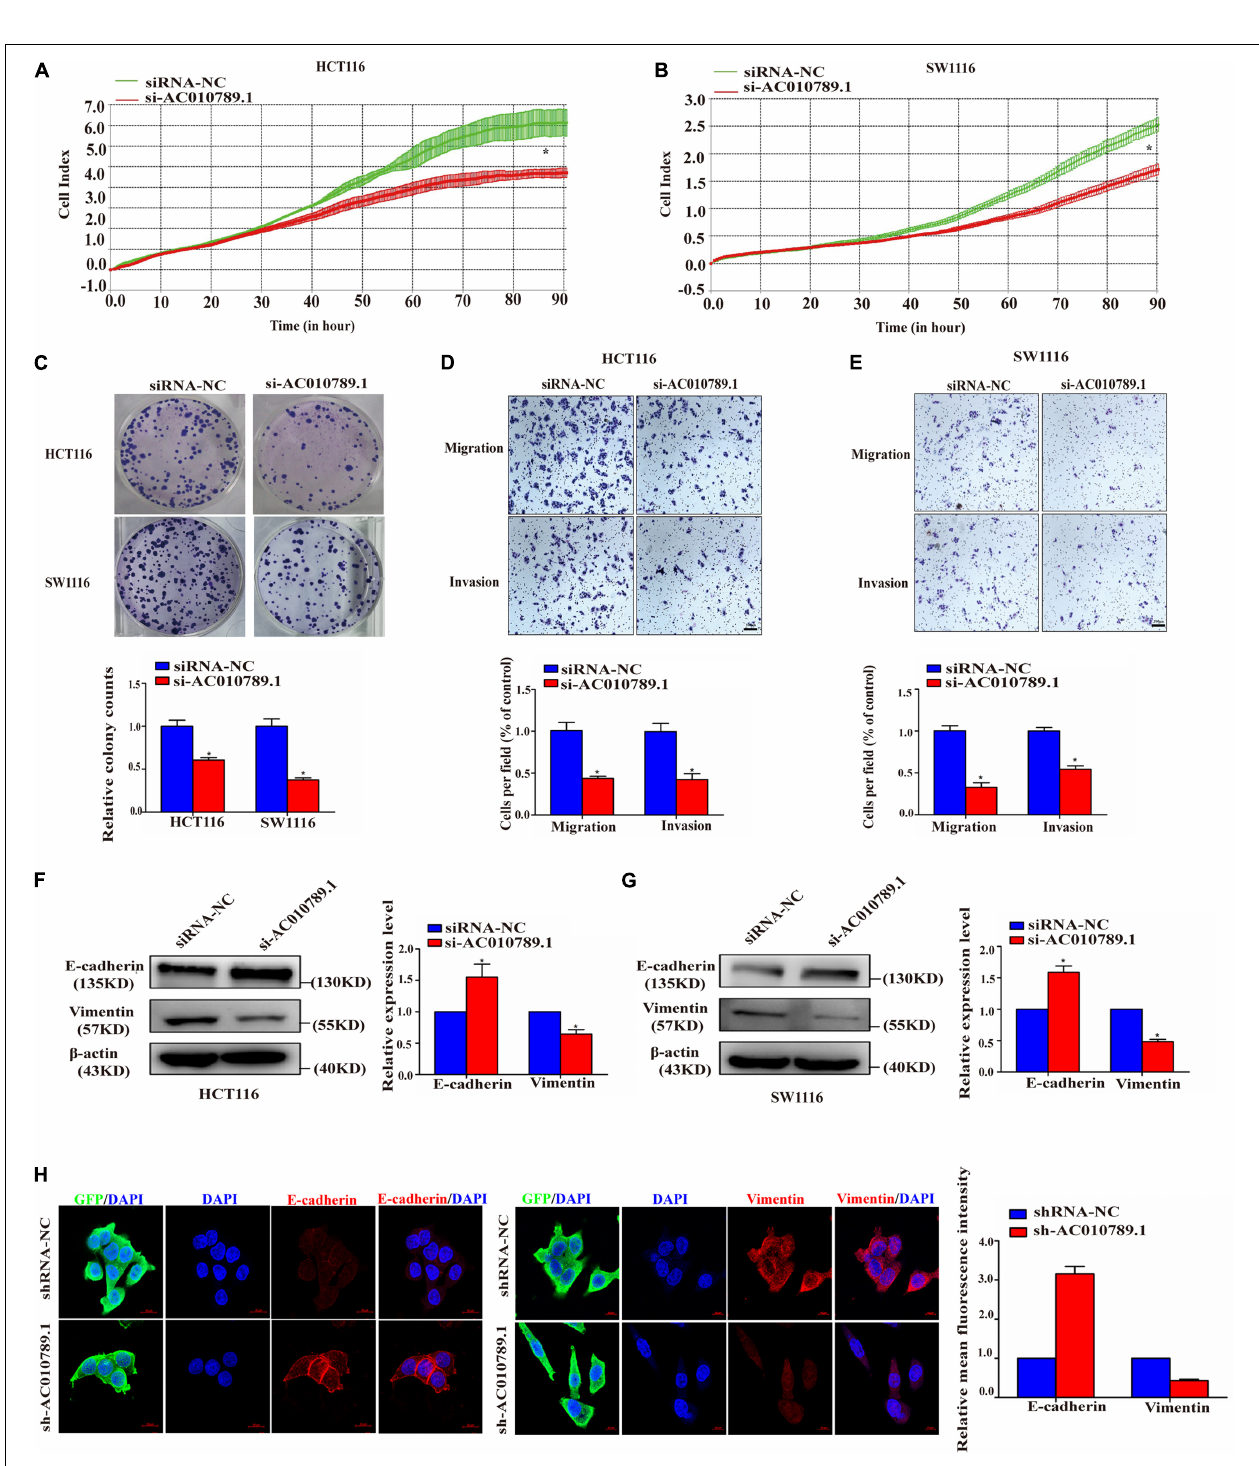
FIGURE 2 | Silencing AC010789.1 inhibits proliferation, migration, invasion, and EMT of CRC cells in vitro. (A,B) The si-AC010789.1 mediated effect on proliferation was monitored by measuring cell impedance using the RTCA instrument. (C) Colony formation assay in HCT116 and SW1116 cells with AC010789.1 knockdown. (D,E) Transwell assay for investigating migration and invasion change in HCT116 and SW1116 cells after AC010789.1 knockdown, Scale bar: 100 µ m. (F,G) The relative expression levels of E-cadherin and vimentin were determined by western blot in HCT116 and SW1116 cells with AC010789.1 knockdown. (H) The shRNA-NC and sh-AC010789.1 stable HCT116 cells were stained with antibodies to E-cadherin (red), vimentin (red) and GFP (green) and then stained with DAPI to detect nuclei (blue). Scale bar: 10 µ m. Data are representative of three independent experiments and are presented as mean ± SEM. P -values were determined by two-tailed student’s t -test (* P <